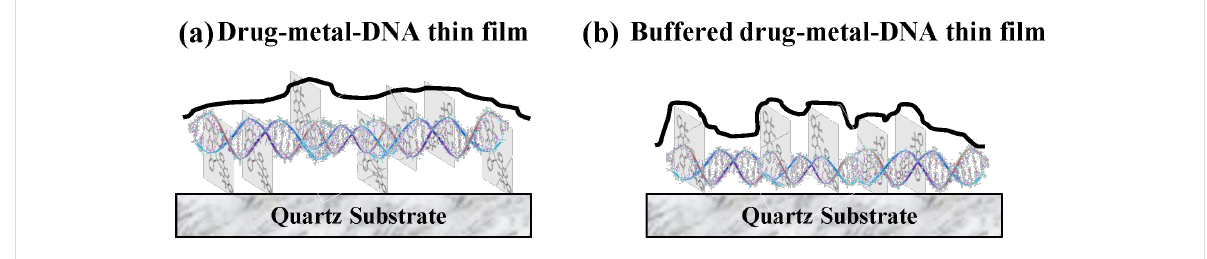
Figure 5: Schematic of (a) metal–drug–DNA film and (b) metal–drug–DNA–buffer film.